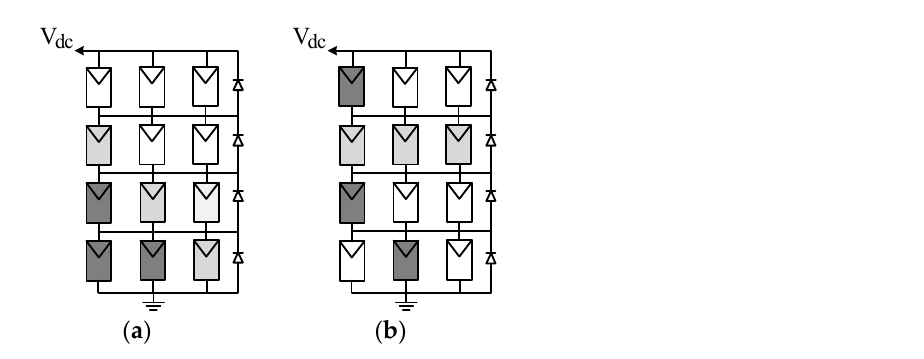
Figure 9. Illustration of the reconfiguration strategy: initial ( a ); irradiance equalized ( b ) [22]. The principle of the Improved IEq strategy [24] is grouping the shaded panels of the dynamic TCT array into weak columns, as illustrated in Figure 10. Hence, the limitation from the main bulk of the array can be removed, helping to attain IEq and higher energy production.